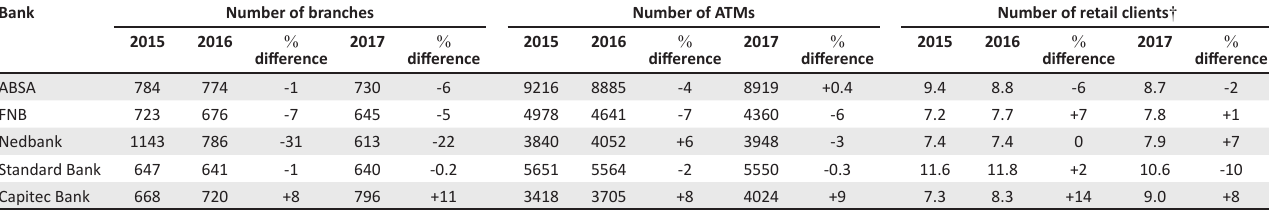
TABLE 1: The number of branches, automated teller machines and clients for the big South African banks. Bank Number of branches Number of